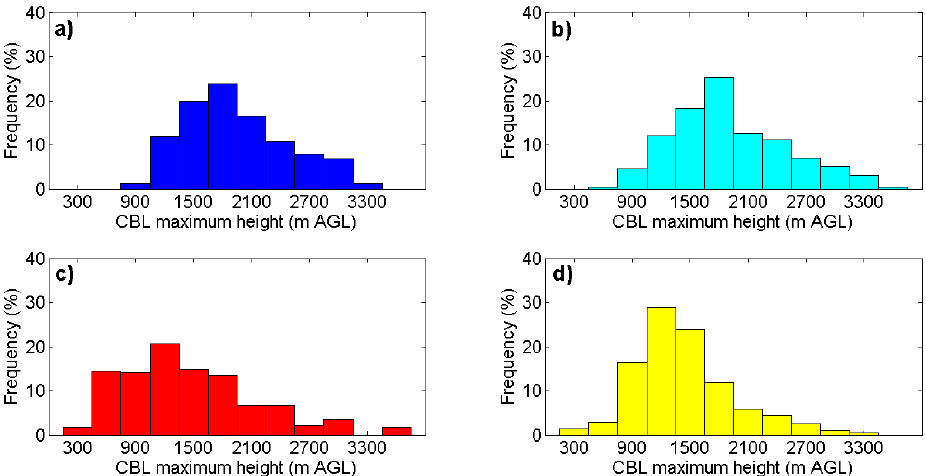
Fig. 6. Histograms for measured and modelled PBL top daily maximum heights during 2010, (a) Polly XT , (b) ECMWF, (c) SAWS and (d)